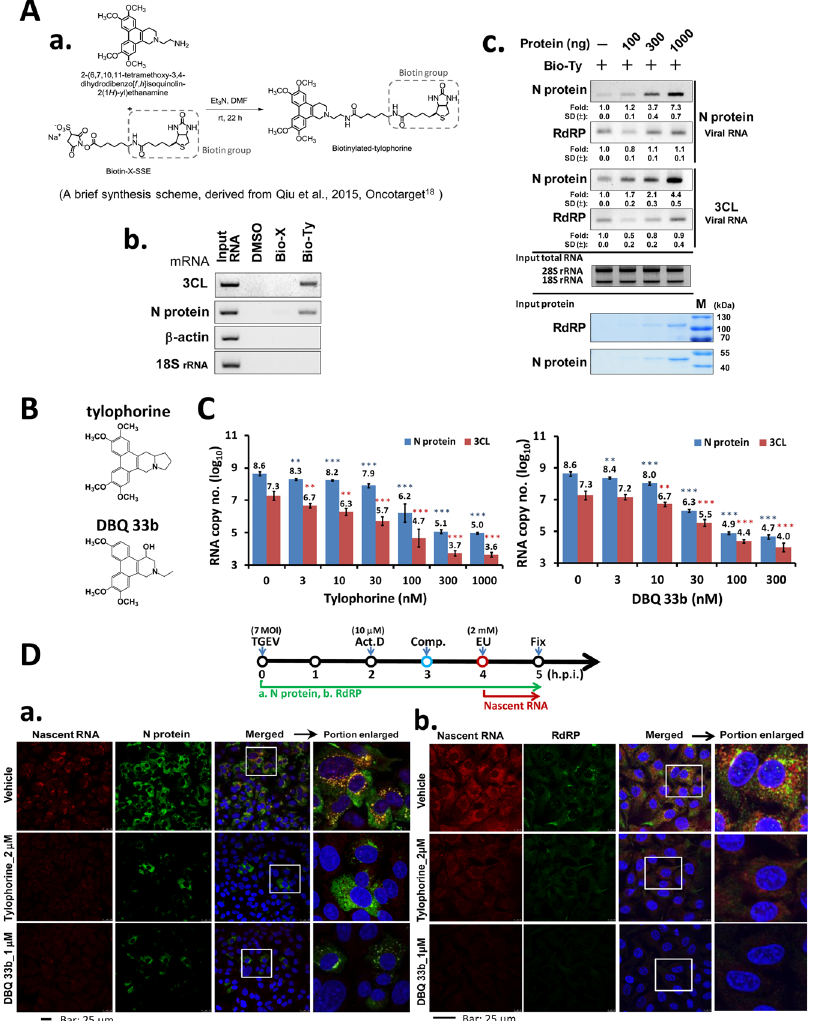
Figure 1. Tylophorine compounds inhibited TGEV RNA replication through interaction with TGEV viral RNA/RNP. ( A ) Tylophorine compound interacted with TGEV viral RNA. (a) A brief synthesis scheme, derived from Qiu et al . 18 . (b) Biotinylated tylophorine interacted with TGEV viral RNA. (c) TGEV N protein enhanced the association of biotinylated tylophorine with TGEV viral RNA. The total RNAs (5 µ g) extracted from TGEV infected ST cells at 6 h.p.i. were subjected to pull-down experiments with 30 µ M of biotinylated tylophorine or Biotin-X-SSE at 4 °C for 4 h in the absence or presence of recombinant N protein or His-RdRP with the indicated amount. The pulled down complexes were subjected for analysis by RT-PCR with TGEV specific primers, designed from the regions of TGEV N or 3CL pro gene body. 18/28S ribosomal RNAs were used as the input controls for pull-down assays. Biotinylated tylophorine and Biotin-X-SSE were respectively labeled as Bio-Ty and Bio-X. ( B ) Chemical structures of tylophorine and DBQ 33b. ( C ) Tylophorine compounds inhibited TGEV replication. TGEV infected ST cells at an MOI of 7, treated with the indicated doses of compounds at 6 h.p.i. were harvested and subjected for total RNA extraction and the determination of the viral copy numbers (see Materials and Methods). Shown are means ± S.D. from three independent experiments each in triplicates. ( ** p < 0.01 & *** p < 0.001; versus no compound treatment). ( D ) Tylophorine compounds inhibited TGEV nascent viral RNA replication and N and RdRP protein expression. TGEV infection, compound treatments and EU addition for labeling nascent RNA were performed in the sequence in the upper scheme as the shown black arrow line. The green arrow line represented the period of N (a) or RdRP (b) protein expression since TGEV infection and the red one for the nascent RNA synthesis since EU addition. Actinomycin D (Act. D) was added at 2 h.p.i. to inhibit DNA-dependent RNA polymerase. For immunofluorescent staining, following fixation, the cells were detected for the incorporated alkyne-modified EU with azide-derivatized Alexa 594 fluorophores by using click chemistry for nascent viral RNA (red), immuno-stained with FITC-mouse IgG for anti-TGEV N (a) or RdRP (b) protein (green) and stained with 4 ′ ,6-diamidino-2-phenylindole (blue) for visualizing nuclei. The fluorescence image was acquired by using a Leica TSC SP5 laser-scanning confocal microscope. Bar: 25 μ m. Uncropped images for Fig. 1A are presented in Supplementary Figure